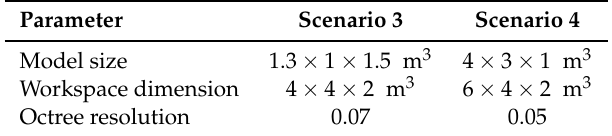
Table 4. The parameters of the Guided NBV used in the two real experiments